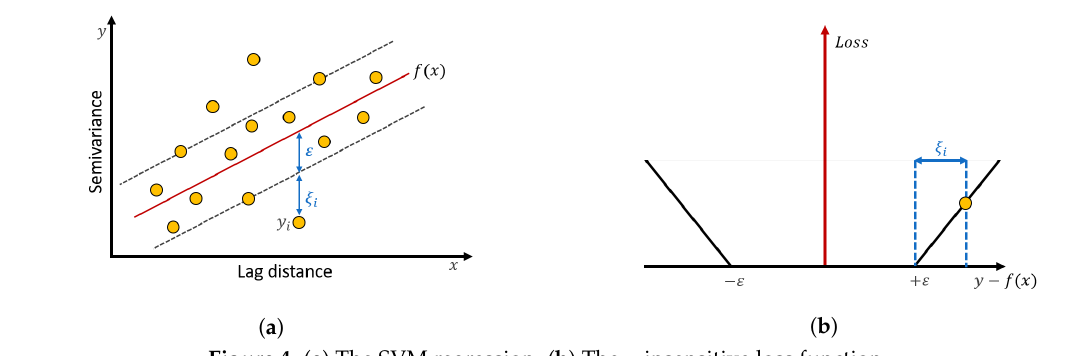
Figure 4. ( a ) The SVM regression. ( b ) The ε -insensitive loss